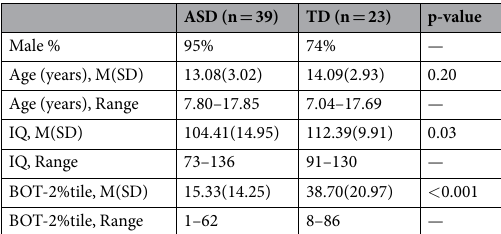
Table 1. Participant demographics. Note : BOT-2 = Bruininks-Oseretsky Test of Motor Proficiency, 2 nd edition; IQ = Intelligence Quotient; M = Mean; SD = Standard